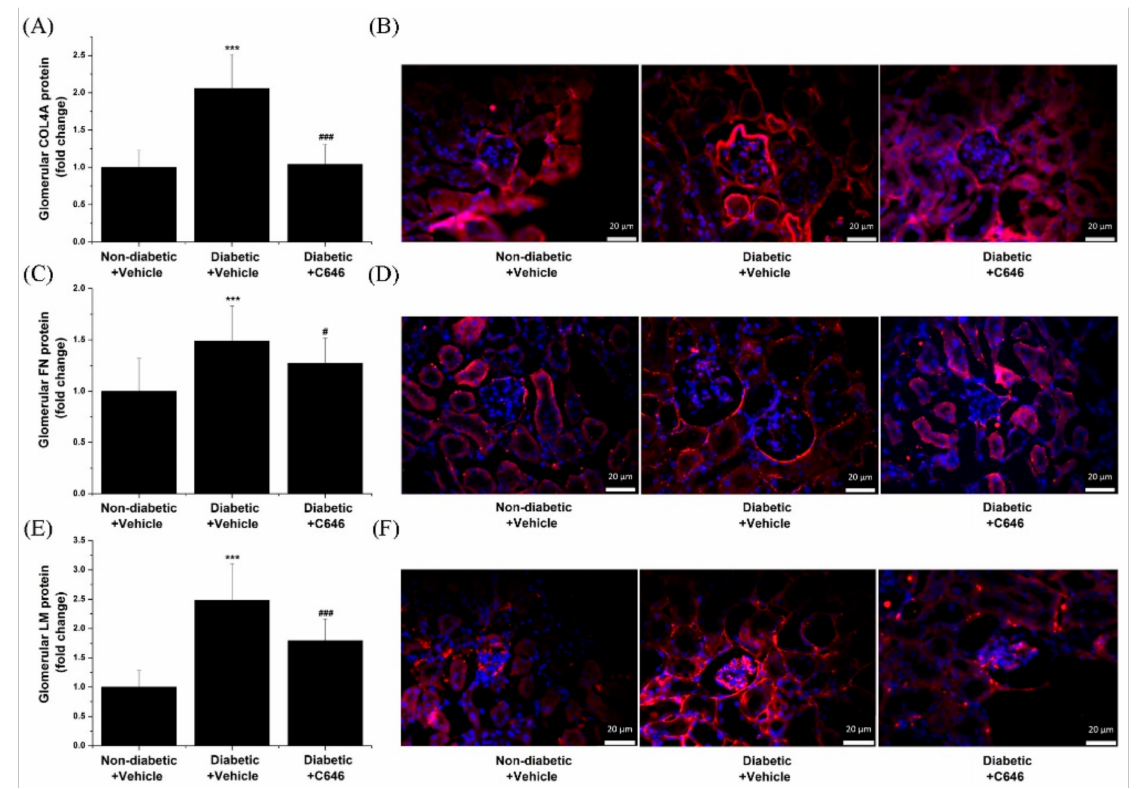
Figure 9. Blockade of histone acetyltransferase p300/CBP reduces the glomerular expression of extracellular matrix proteins collagen IV, fibronectin, and laminin in diabetic mice. ( A , C , E ) Quantification of fluorescence immunolabeling for glomerular collagen IV/COL4A, fibronectin/FN, and laminin/LM. ( B , D , F ) Representative immunofluorescence (IF) microscopy images taken at 40 × magnification depicting the IF staining (red) for COL4A, FN, and LM. Sections were counterstained with the DAPI stain (blue) to detect the cell nuclei in the specimens. n = 18–23/condition quantified glomeruli, *** p < 0.001, p -values taken in relation to non-diabetic + vehicle condition; # p < 0.05, ### p < 0.001, p -values taken in relation to diabetic + vehicle